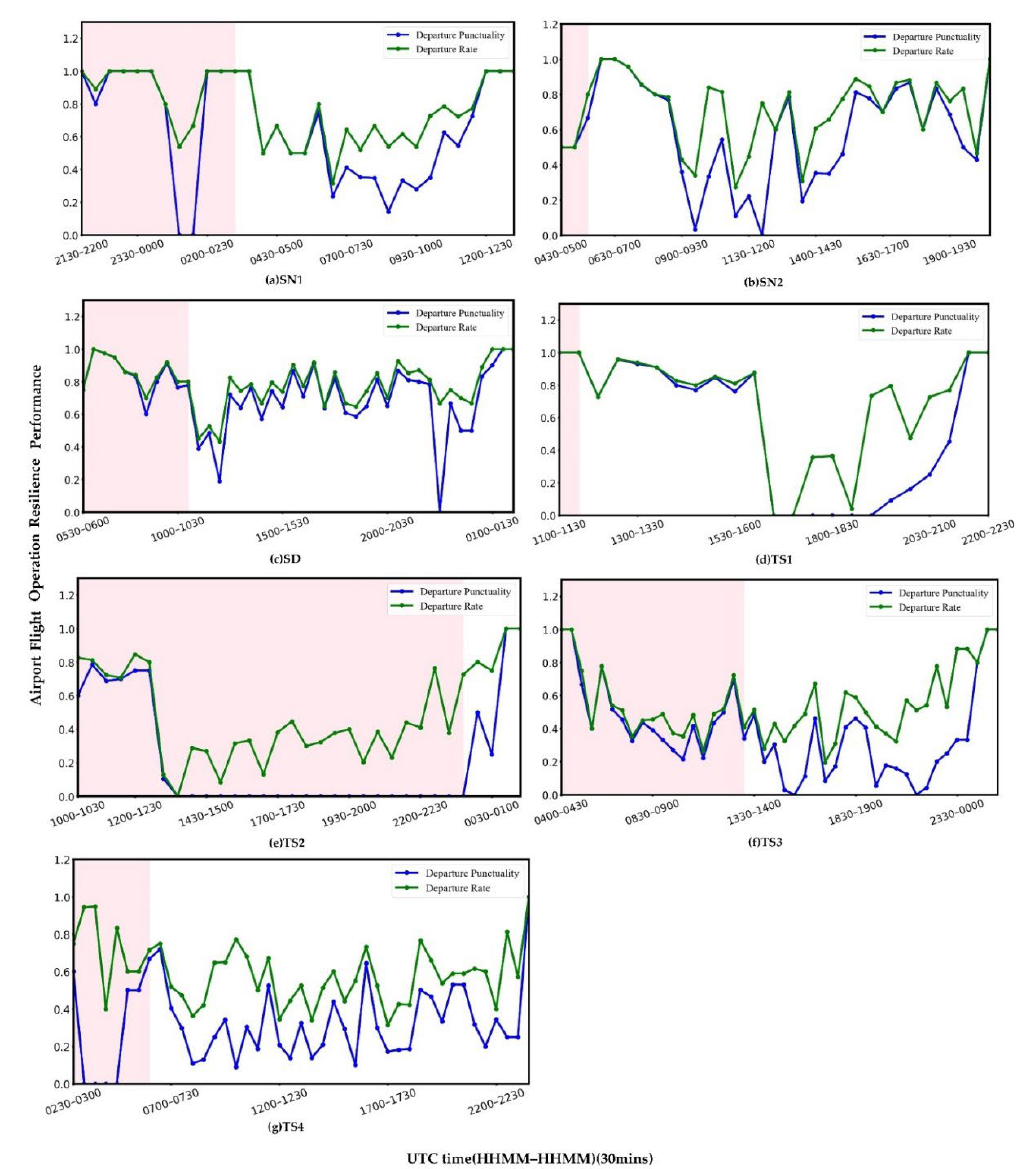
Figure 2. Comparison of DPR and DPP under severe weather conditions. The red area represents the occurrence period of severe weather, the green line segment represents DPR, and the blue line segment represents DPP.